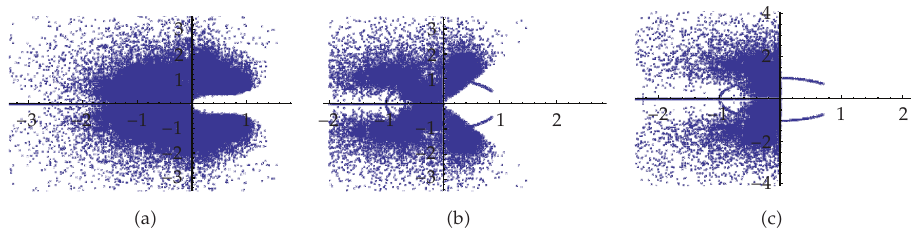
Figure 7: (cid:5) a (cid:6) The position, on the complex plane, of the zeros of 50000 random integer polynomials with coe ff cients between 0 and 2500000. (cid:5) b (cid:6) The same, but with monic palindromic octics. (cid:5) c (cid:6) Monic palindromic octics, and with linear term vanishing.